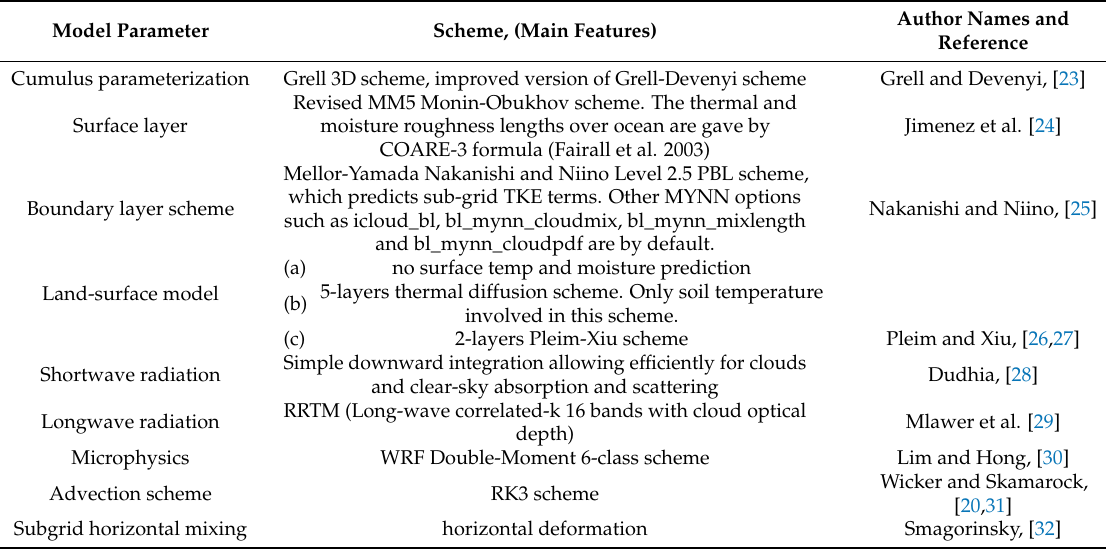
Table 2. The parameterizations of the WRF-ARW meteorological